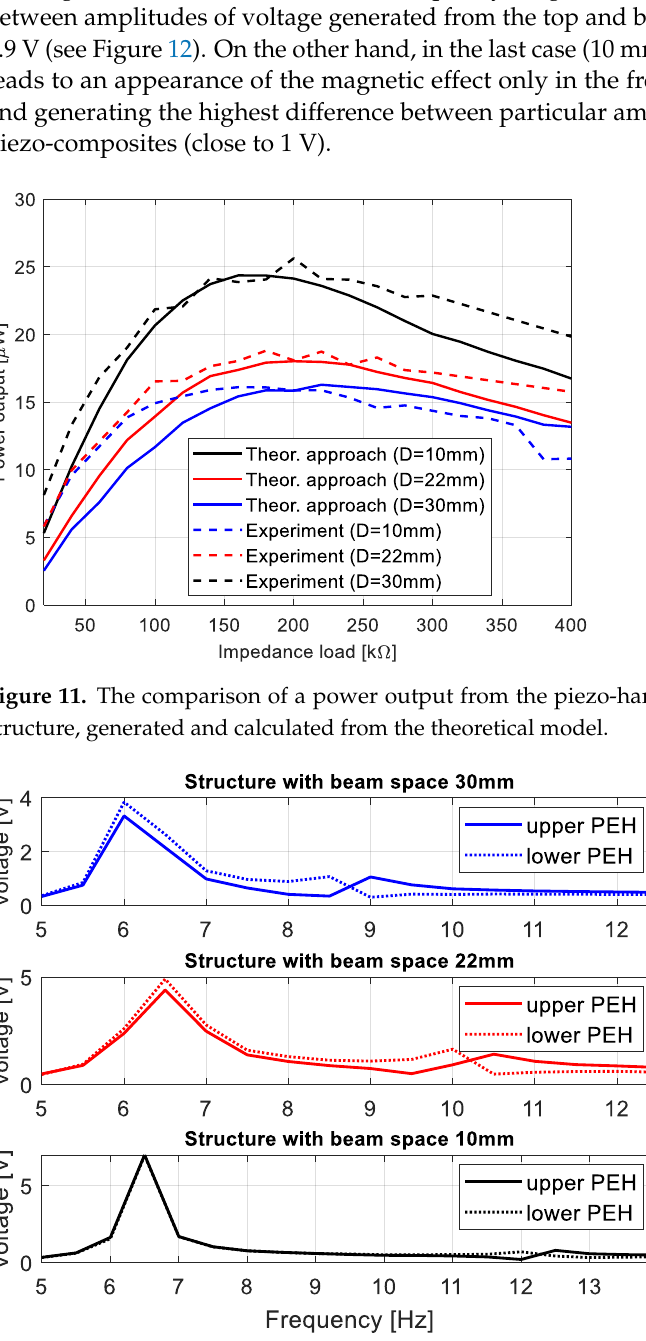
Figure 11. The comparison of a power output from the piezo-harvester located on the top of the structure, generated and calculated from the theoretical model.